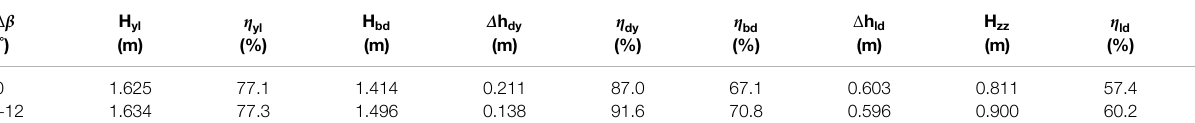
TABLE 3 | Comparison of energy performance parameters of pump devices with Δβ of 0 ° and − 12 ° .